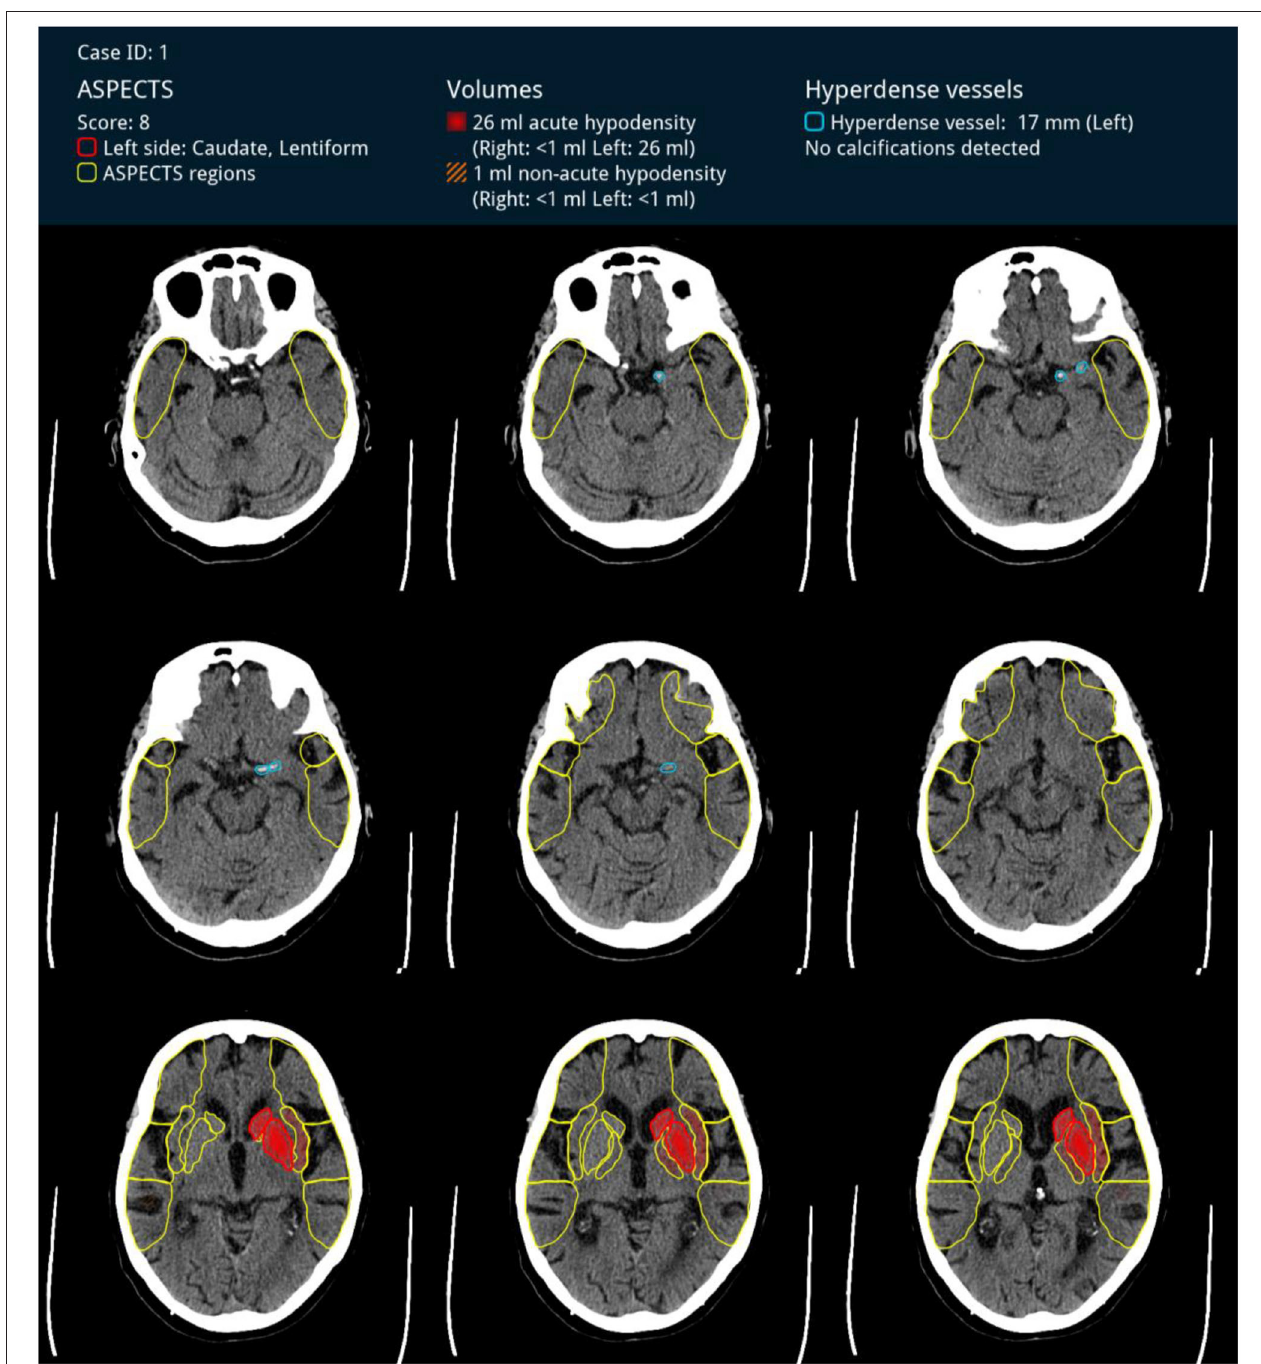
FIGURE 1 | Visualization of the software output—hyperdense artery sign (encircled in light blue) in the M1 segment together with early ischemic changes in the caudate and lentiform nucleus (marked in red) in a patient with acute M1-occlusion on the left side.